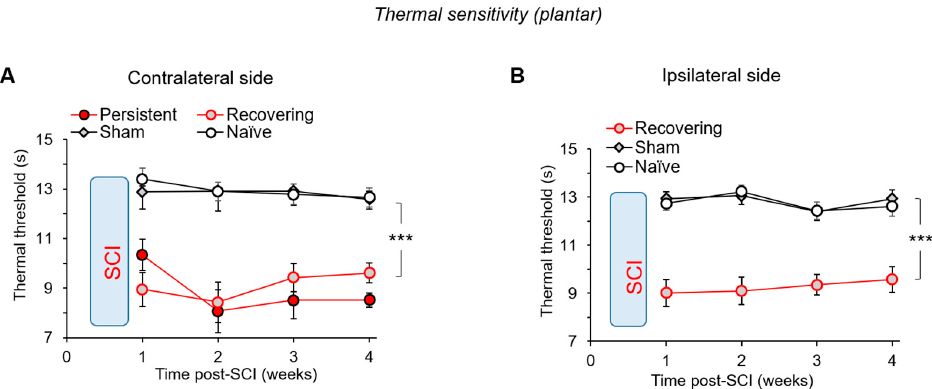
Figure 5. The plantar thermal hypersensitivity after a mild SCI. ( A ) The time-dependent changes in the nociceptive threshold to thermal stimulation—the Hargreaves test latency—show the thermal hypersensitivity on the contralateral hind paw in all injured rats (n = 11 naïve, n = 14 sham-operated animals, n = 8 ‘persistent’ and n = 15 ‘recovering’ SCI animals). ( B ) Same as for A, but for the ipsilateral hind paw. Data are mean ± SEM. *** p < 0.001 (ANOVA with Tukey post-hoc test).